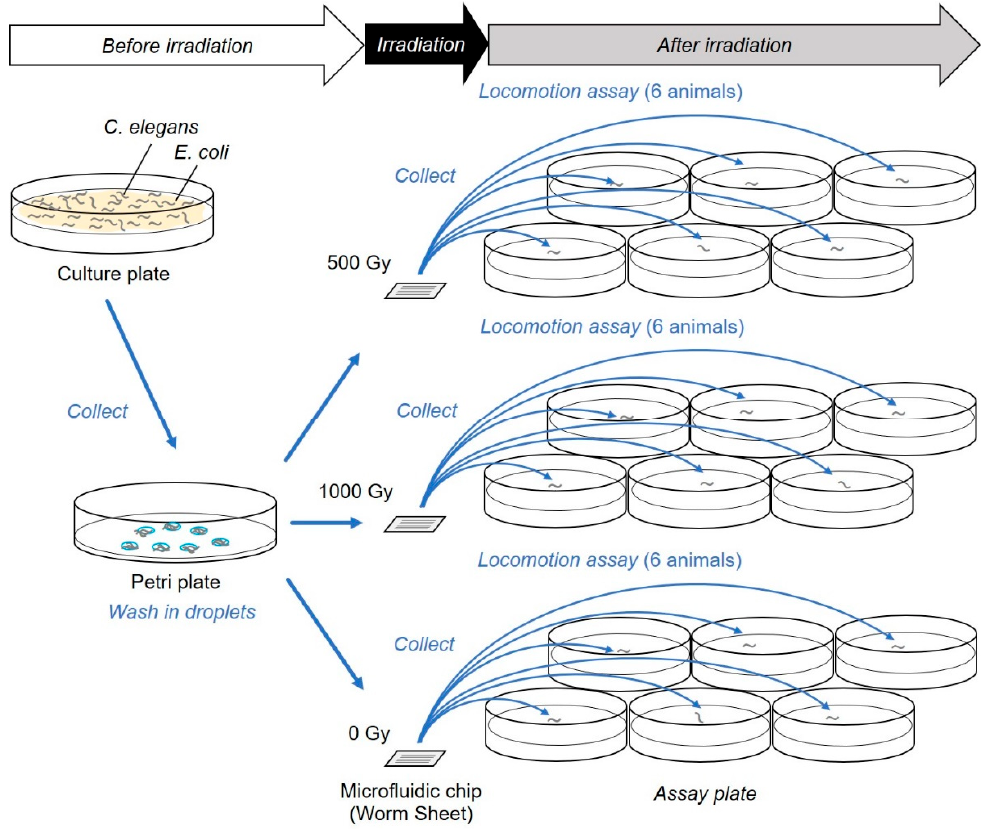
Figure 2. Schematic depiction of the experimental method. The procedure of the targeted-irradiation and locomotion assay using independent microfluidic chips for each dose of irradiation and assay plates for each animal. This was used in the experiments described in Section 3.1.